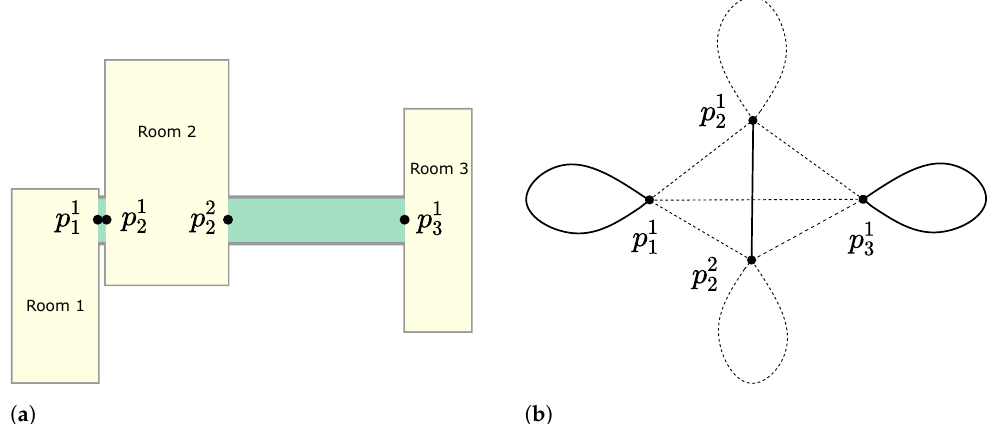
Figure 2. Example of a segmented map and its corresponding graph used for tour planning. We observe that each room is only accessible by the door points. In the corresponding graph, the door points are converted to vertices, while the movements through rooms and corridors are converted into edges. To cover all the rooms, the edges drawn with continuous lines must be travelled, while the edges drawn with dotted lines to be travelled in the formulation of the rural postman problem are optional. ( a ) Segmented map and door points. ( b ) Corresponding